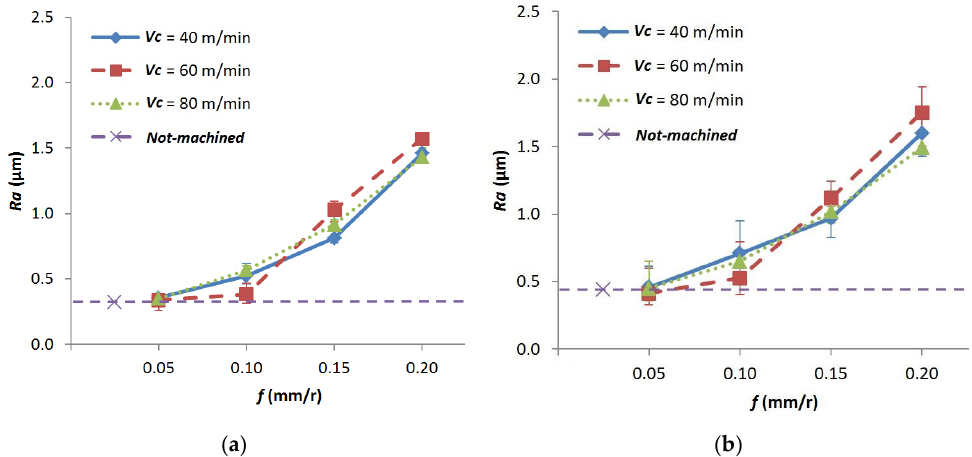
Figure 4. Average roughness ( Ra ) as a function of feed ( f ) and cutting speed ( v c ), ( a ) before and ( b ) after a corrosion process.